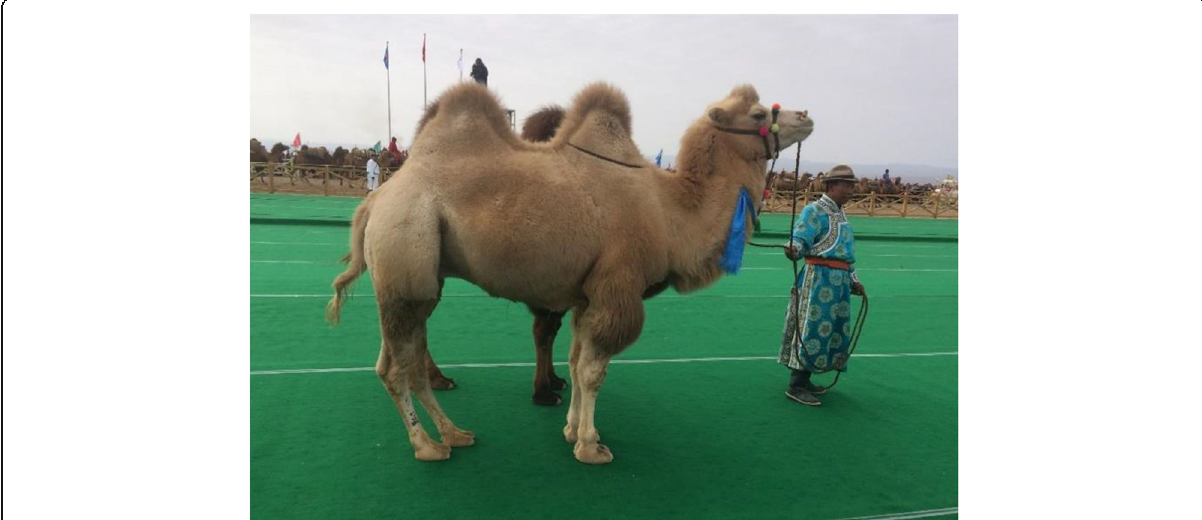
Fig. 6 Bactrian camel at Al-Ashan desert festival, Inner Mongolia, China (Ph. B.